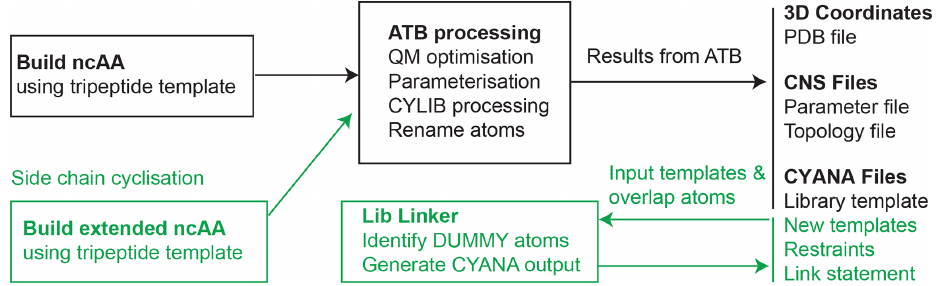
Figure 1. Workflow for generating files for NMR structural calculation of peptides and proteins that contain ncAAs. The input file must be generated using the described template format (Fig. 2) and used as input to the ATB web server, which then recognises the input as an amino acid and excises the necessary portion to generate the required input files for CYANA and CNS-based structure determination software (shown in black on the right). To produce templates suitable for side-chain linkage in CYANA (shown in green), an extended ncAA template containing atoms that extend beyond the linking bond is built (Fig. 4). Two such templates are used as input to the CYANA Lib Linker interface of the ATB, where the user also defines which atoms from the first template are present in the second template and vice versa. The “overlap” atoms of the extension are changed to dummy atoms to produce a new CYANA template file (.lib file), and short upper distance restraints are generated between sets of overlapping atoms (.upl file). A link statement (to be added to the sequence file (.seq) in CYANA) is also produced to remove the repulsion between the two atoms that are to be linked.